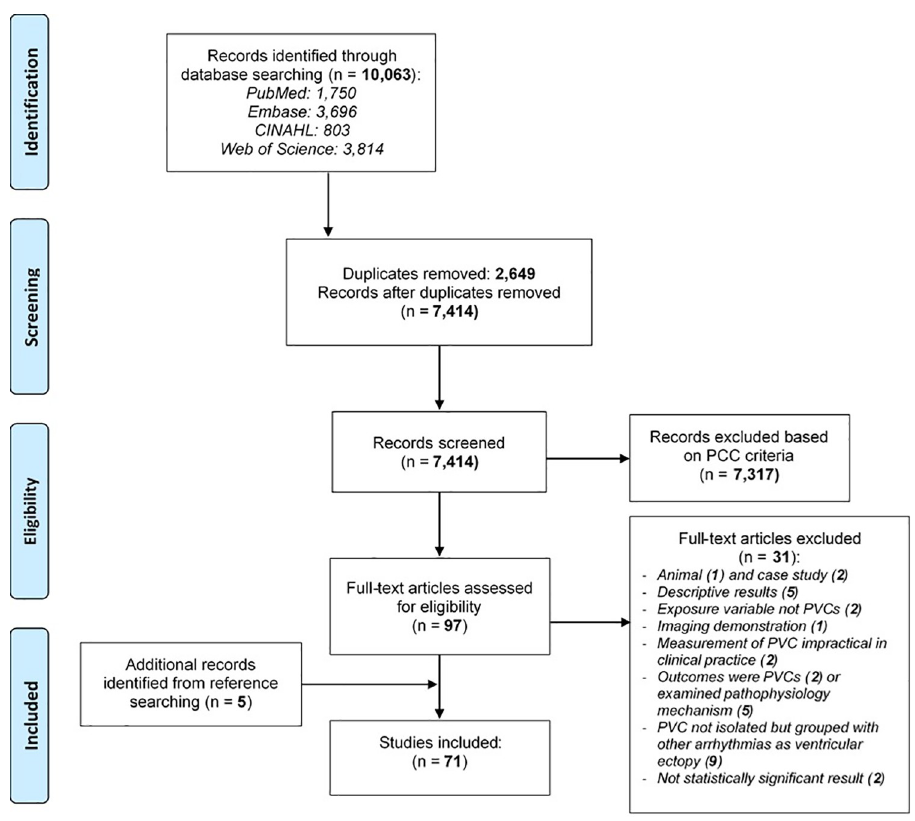
Fig 1. Study selection process and results (adopted from PRISMA 2009 flow diagram [32]). CINAHL = Cumulative Index to Nursing and Allied Health Literature; PCC =